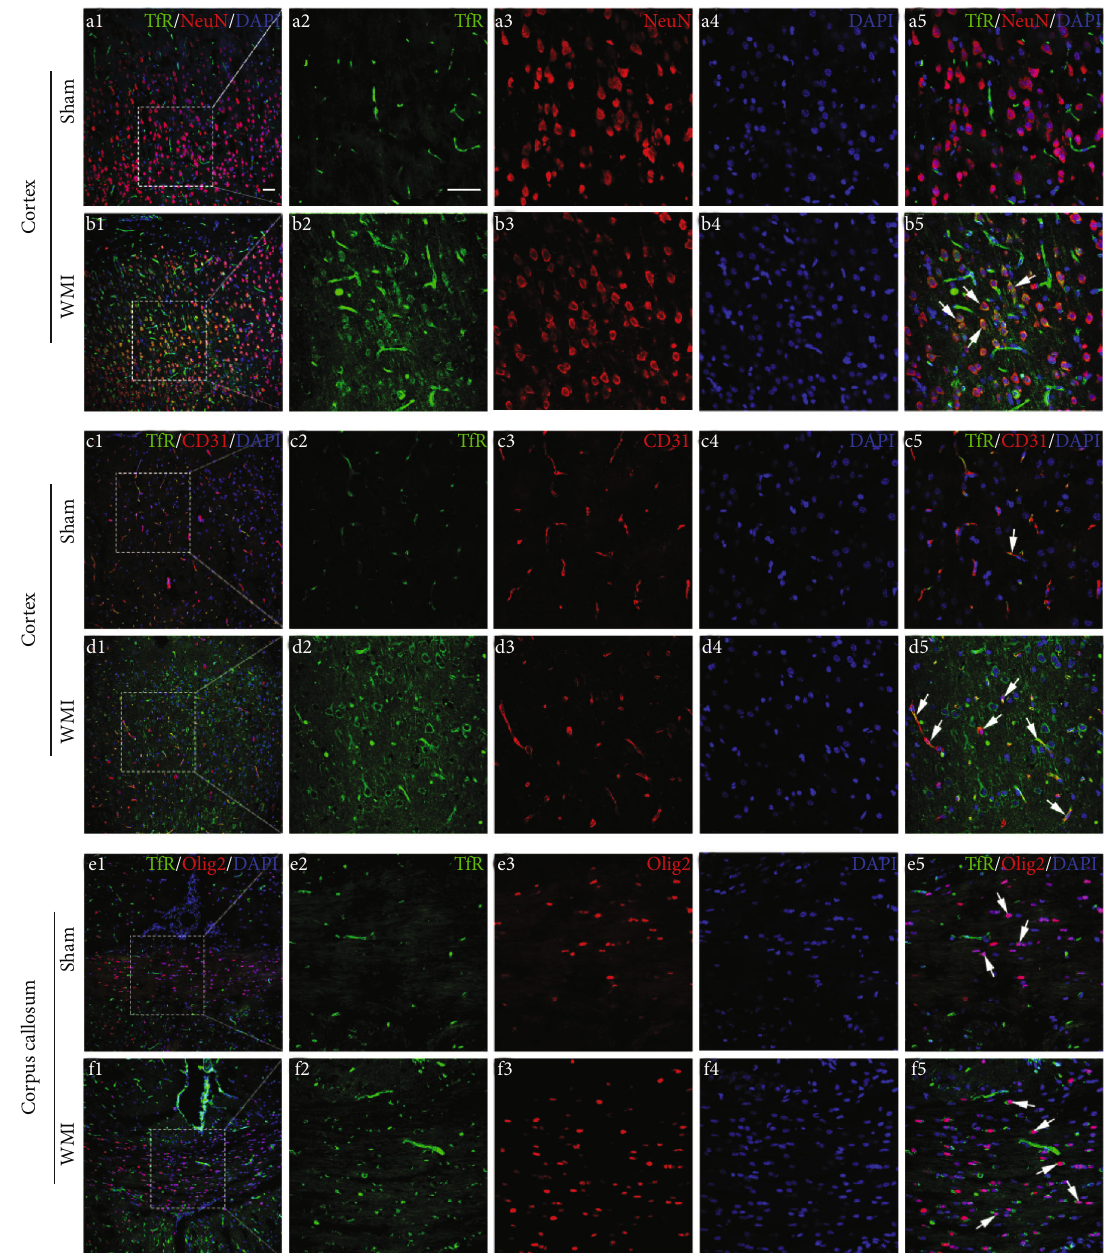
Figure 7: Representative images of immuno fl uorescence staining for TfR (green), NeuN (neuronal marker; red)/CD31 (vascular marker; red)/Olig2 (oligodendrocyte marker; red), and DAPI (nuclear marker; blue) in rat brains on POD 28. TfR-positive cells were colocalized with NeuN- or CD31- or Olig2-positive cells; however, they were largely observed in the WMI group than in the sham group. White arrows indicate TfR + NeuN + cells in b5, TfR + CD31 + cells in c5 and d5, and TfR + Olig2 + cells in e5 and f5. Scale bar, 50 μ